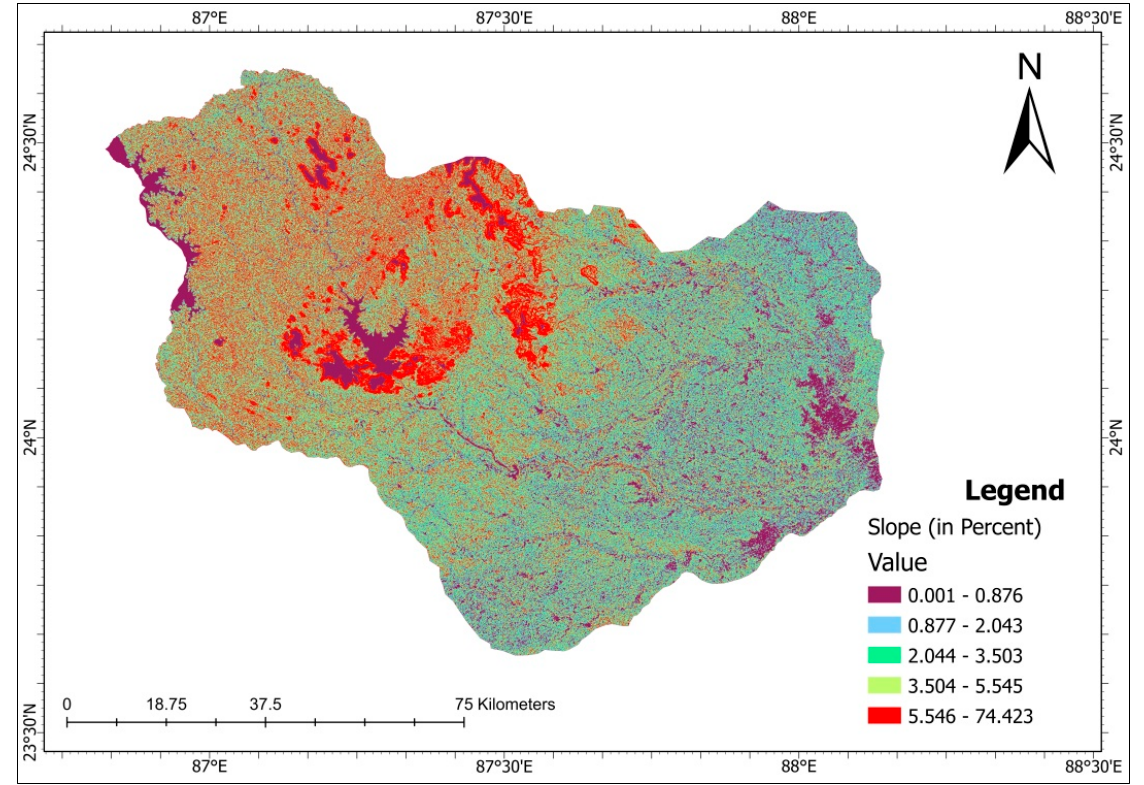
Figure 8. Slope map of the study area.